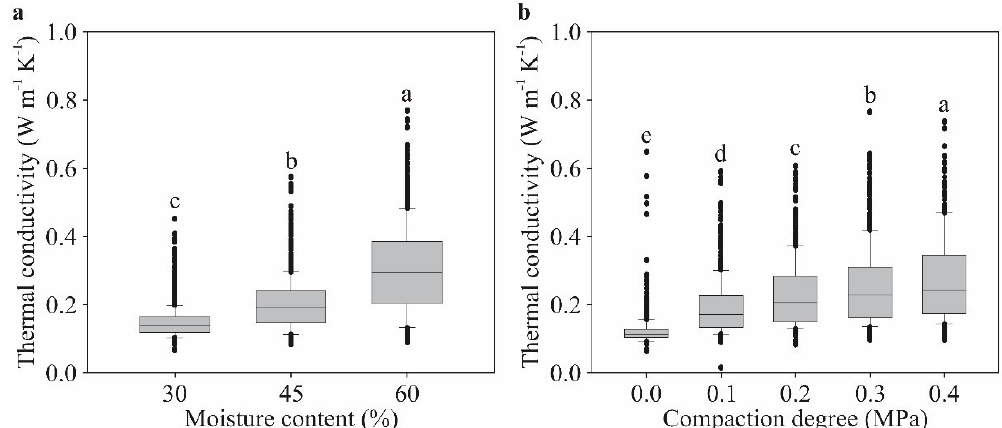
Figure 4. Variation in thermal conductivity ( k ) at different degrees of moisture content ( a ) and ( b ) static compaction degree of compost bedding materials. Values followed by different letters are significantly different ( p < 0.05; Tukey).